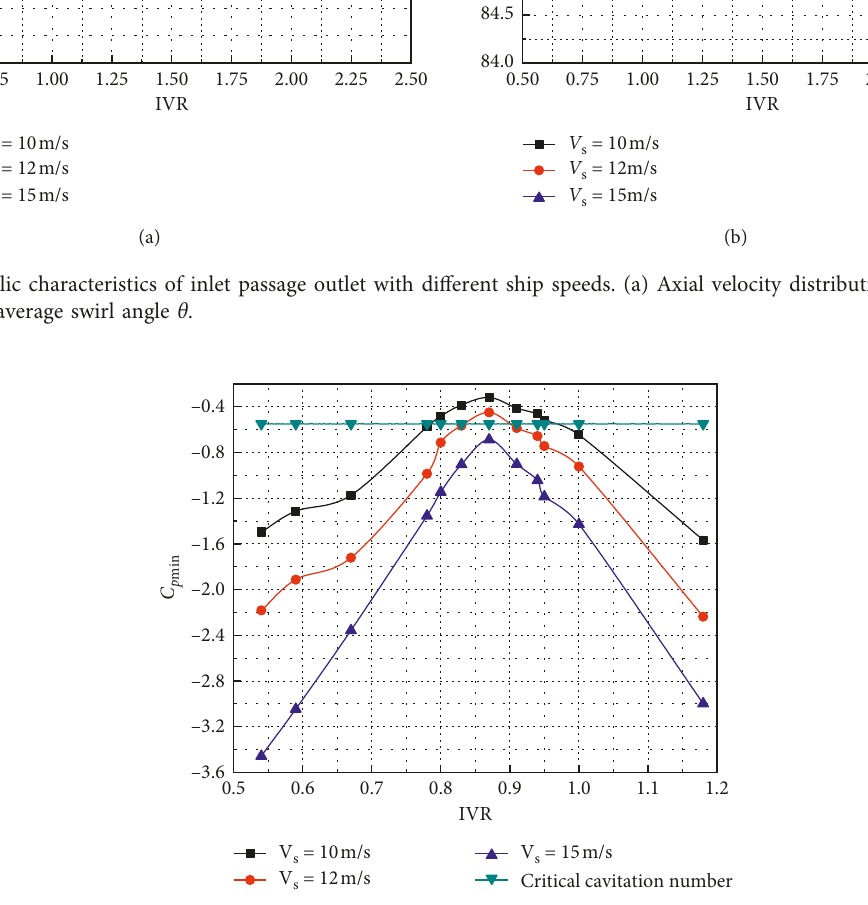
p min with different ship